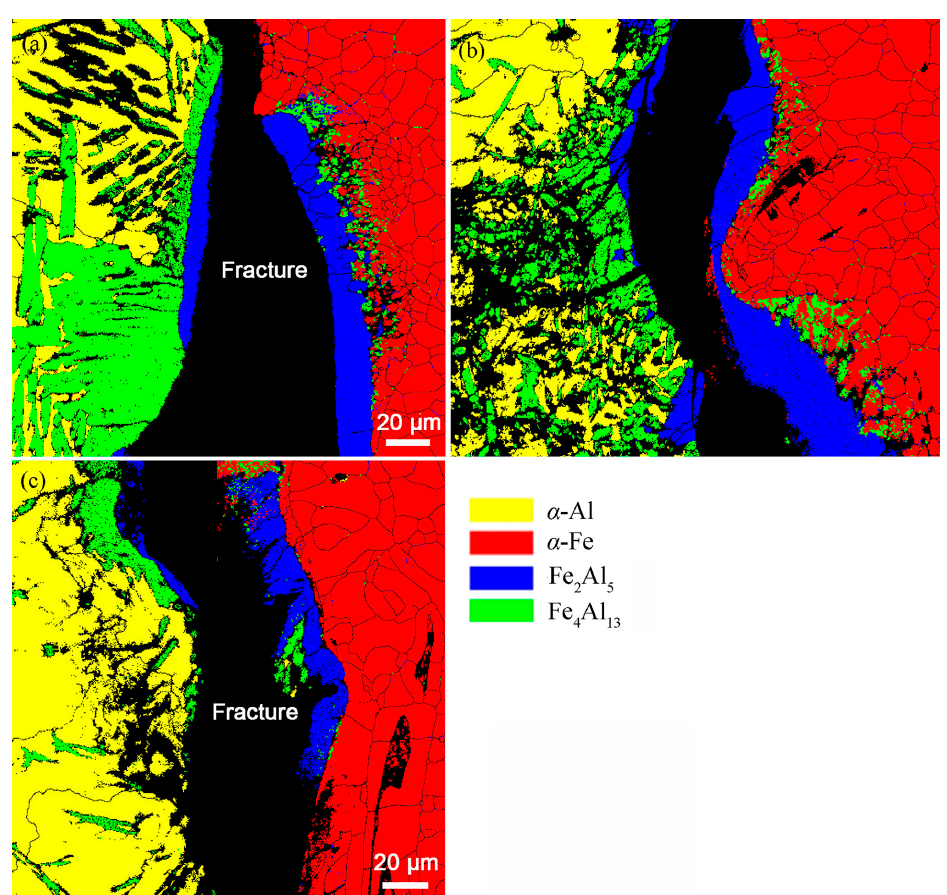
Figure 16. EBSD phase mapping of the failed tensile samples for the Al/steel joint with different laser beam offsets: ( a ) 0.3 mm; ( b ) 0.5 mm; ( c ) 0.7 mm.